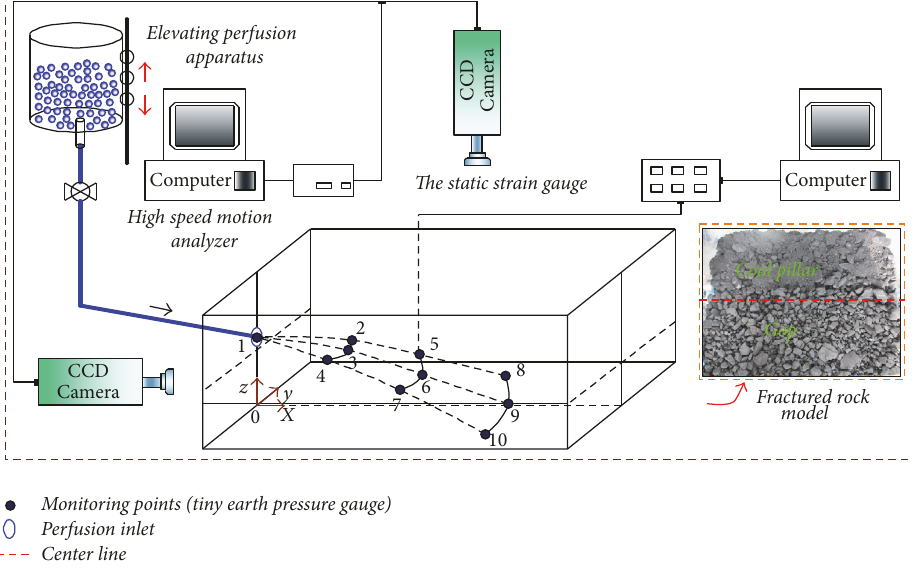
Figure 1: The test